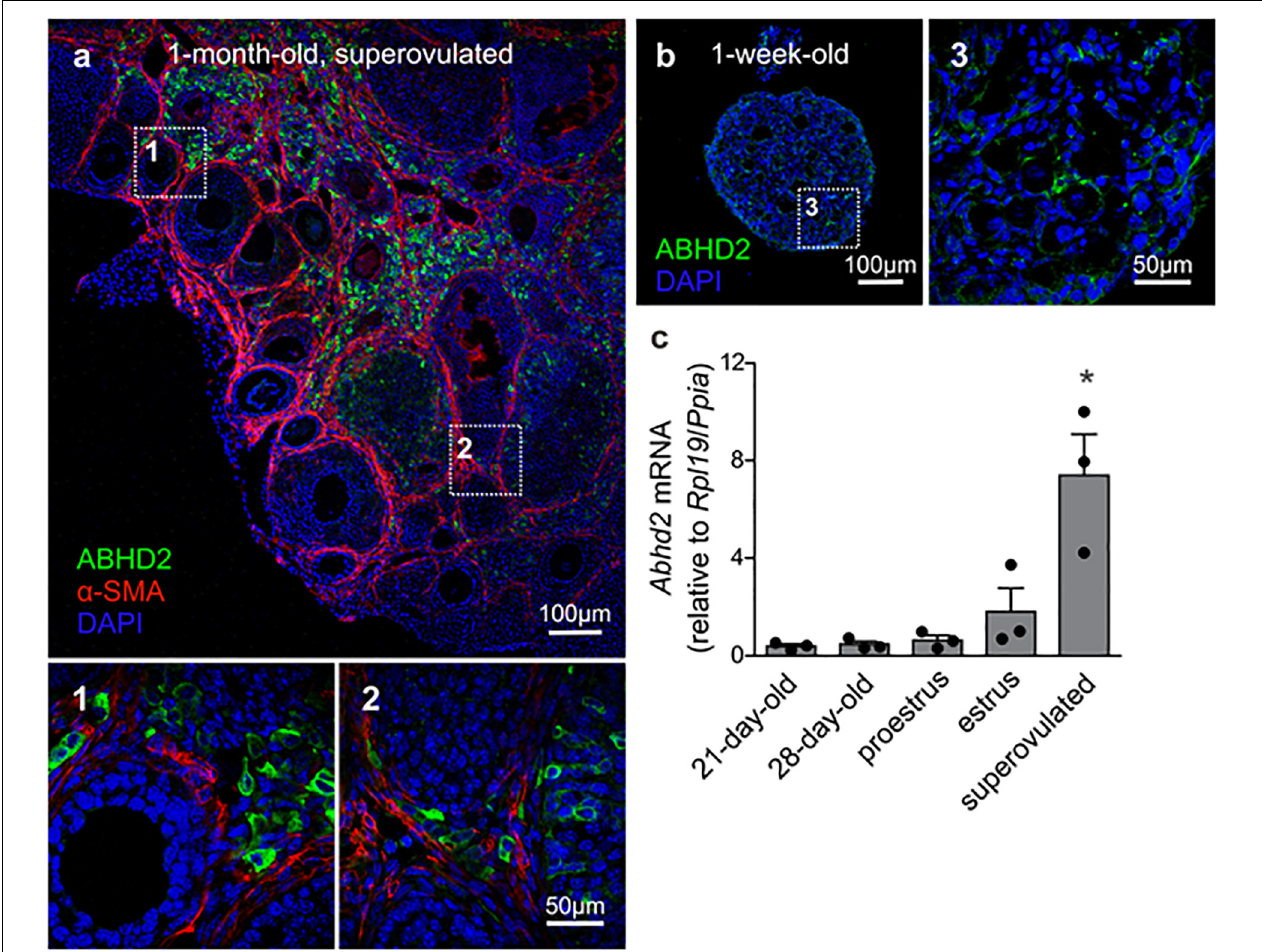
FIGURE 1 | Expression of alpha/beta hydrolase domain-containing protein 2 (ABHD2) in the mouse ovary. (a) Immunohistochemical (IHC) staining of a 1-month-old superovulated wild-type mouse ovary shows ABHD2 in the stromal cells (1) and in cells of the corpus luteum (CL) (2), while the protein is not present in the granulosa cells and oocytes of developing follicles, demarcated by staining of the surrounding smooth muscle layer (b) , and (3) Stromal cells of 1-week-old pre-pubertal mouse ovaries also display ABHD2 staining while (c) shows similar expression levels of Abhd2 before and after the first round of ovulation, as detected in 21- and 28-day-old mice ovaries. The expression levels increase after ovulation, as seen in ovaries at estrus and after superovulation. Samples ( n = 3 for each timepoint) were collected from 3-month-old females in proestrus and estrus and 1-month-old superovulated females. Expression levels measured by qPCR were normalized to the expression of ribosomal protein L19 ( Rpl19 ) and peptidylprolyl isomerase A ( Ppia ). Statistical significance was calculated using the unpaired t -test, and the significance of changes is indicated as follows: * p ≤